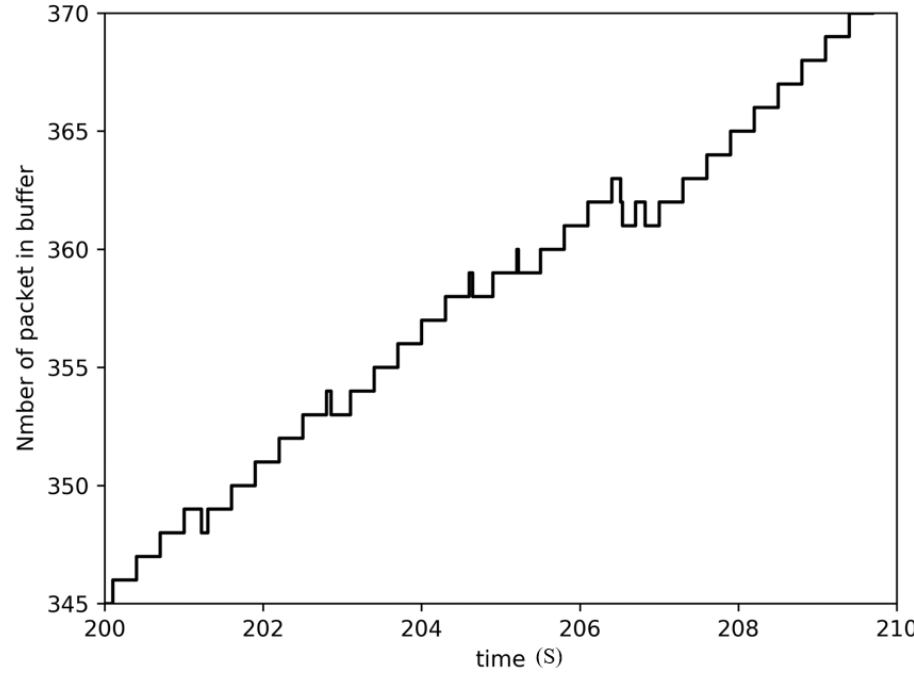
Figure 9. Number of packets in buffer without appropriate DC control.